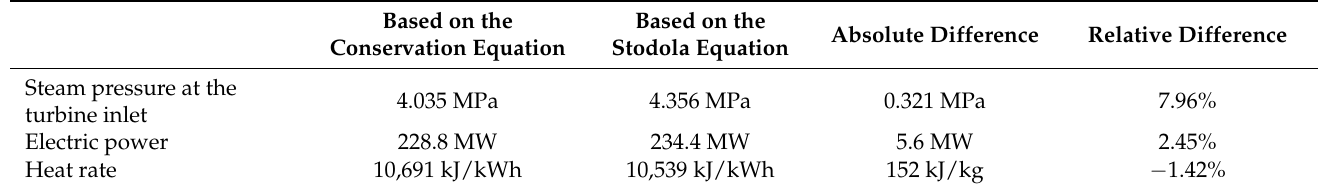
Table 3. Comparison of the calculation results.